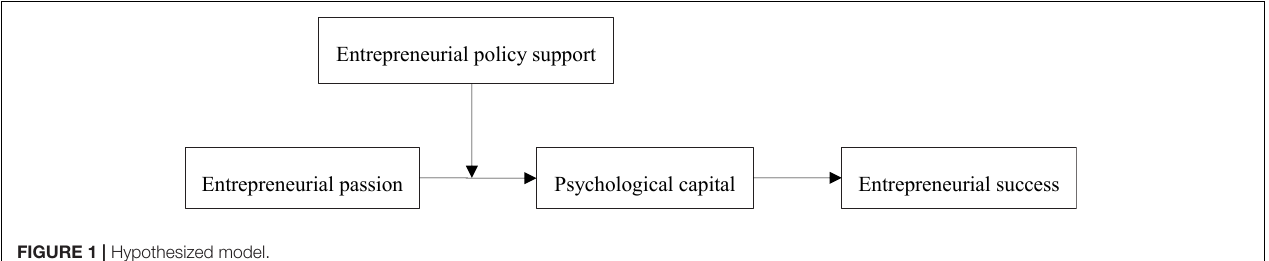
FIGURE 1 | Hypothesized